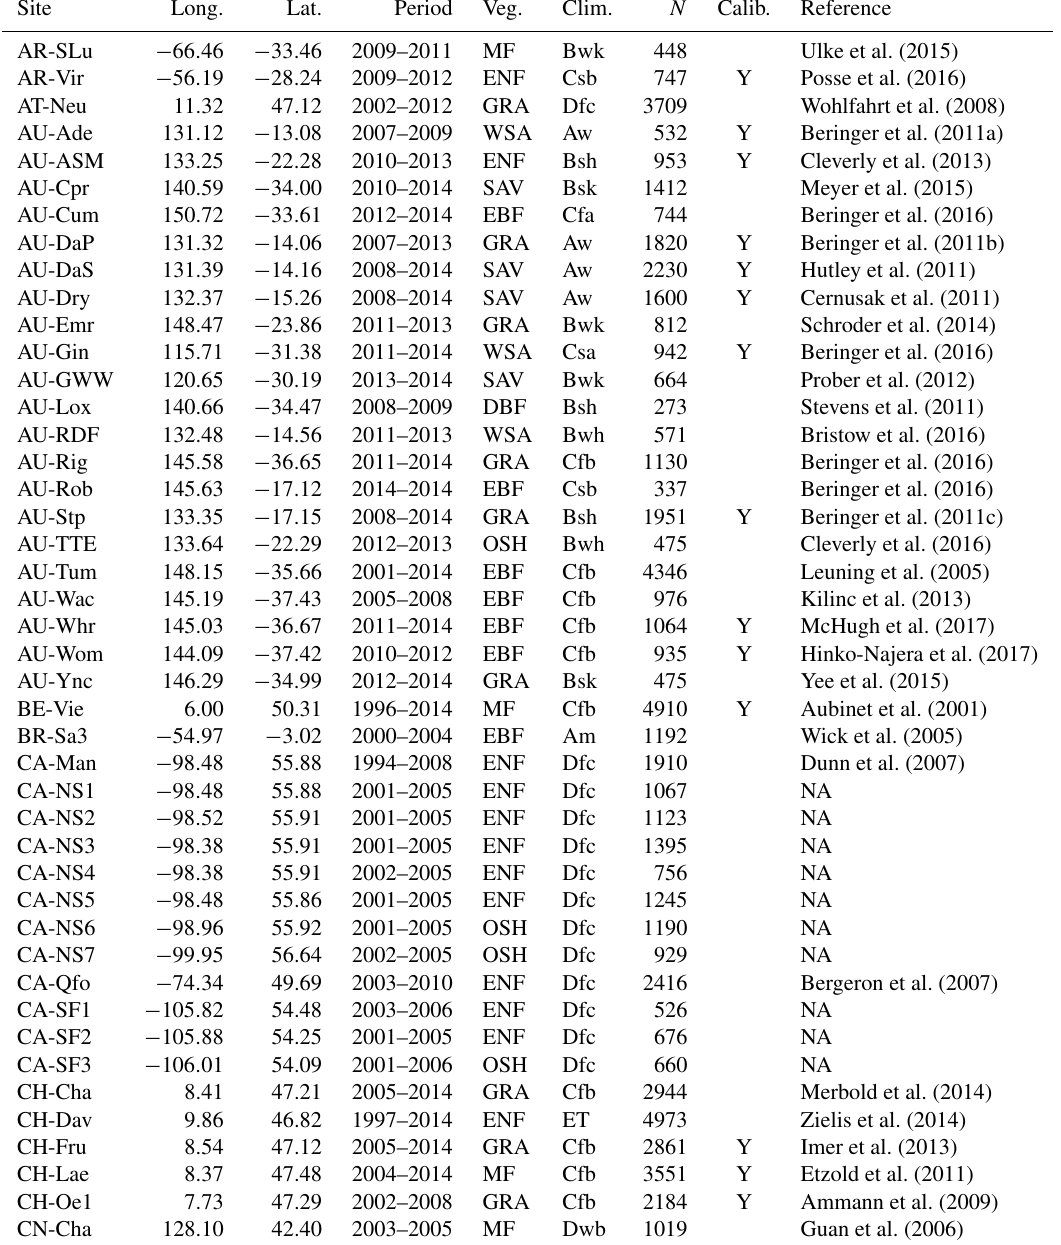
Table A1. Sites used for evaluation. Long. is longitude; negative values indicate west longitude. Lat. is latitude; positive values indicate